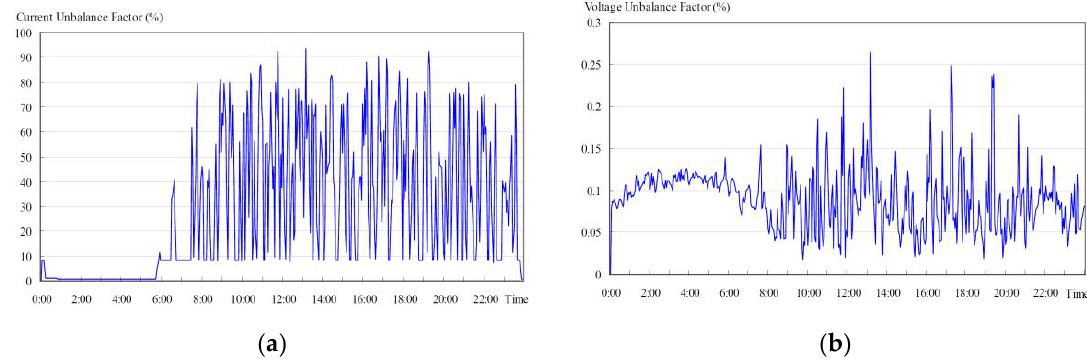
Figure 1. The measured unbalance ratio in Wuhan–Guangzhou high-speed electrified railway system: ( a ) Current unbalance factor; ( b ) Voltage unbalance factor [41].